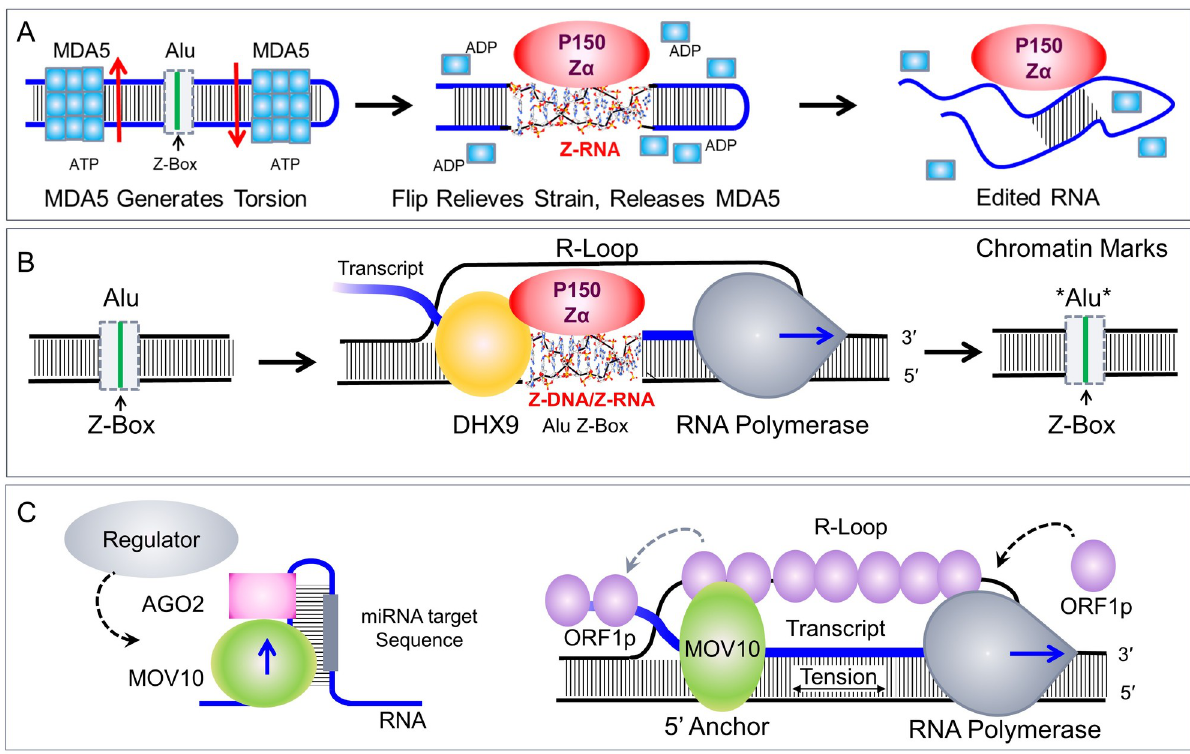
Fig 3. Different roles for helicases in self-recognition, with RNA strands drawn in blue and DNA strands in black. (A) It is proposed that MDA5 induces Z-RNA formation in dsRNA by twisting and shortening the dsRNA. The strain induced promotes the flip to the longer Z-RNA helix, acting like a pull-switch to stop MDA5 filament formation. Alu retroelements contain a highly conserved Z-Box with sequences that favor Z-formation. Once Z-RNA is engaged by its Z α domain, ADAR1 deaminates adenosine to form inosine, destabilizing the dsRNA and preventing MDA5 filament formation. Both outcomes prevent the activation of interferon responses. (B) It is proposed that another helicase, DHX9, anchors R-loops when splicing is inhibited, localizing ADAR1 p150 to Alu Z-boxes in underwound regions of the DRH where Z-formation occurs, altering the transcript produced. Epigenetic marks on Alu chromatin following transcription are indicated by an asterisk—they threshold future responses. (C) The MOV10 normally unwinds dsRNA to allow the access of miRNAs and AGO2, a component of the RISC to their target sequences. This mechanism is one where specific self-sequences recognition enables suppression of immune responses in the normal state [100]. Alternatively, proteins, such as and FMRP [99] stabilize the MOV10 complex with its substrate and protects transcripts from suppression by RISC. It is proposed that a similar type of interaction with the LINE LI ORF1p locks MOV10 in place, anchoring the 5 0 end of the transcript. The DRH formed are targets for RNaseH2. As described in the text, segments within the DRH may flip to the Z-conformation, causing ZBP1 activated necroptosis. With the helicase fixed in place, the movement of RNA polymerase tensions the element, powering the flip. AGO2, Argonaute2; DHX9, DExH-box helicase 9; DRH, DNA:RNA hybrid; dsRNA, double- stranded RNA; FMRP, fragile X mental retardation protein; MDA5, melanoma differentiation–associated gene 5; miRNA, microRNA; MOV10, Mov10 RISC complex RNA helicase; ORF1p, open reading frame 1 protein; RISC, RNA-induced silencing complex.